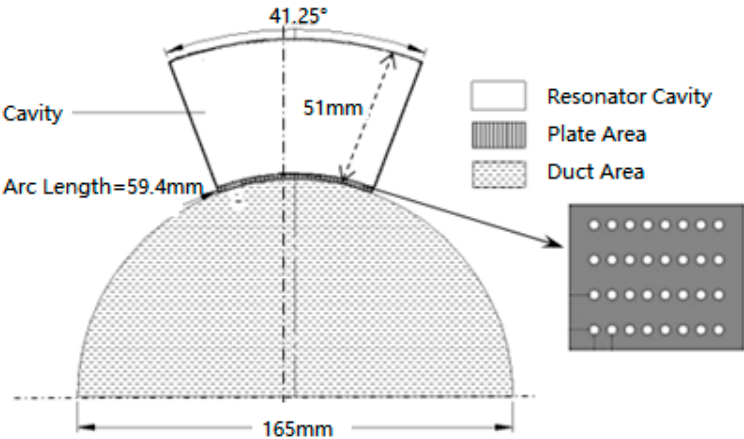
Figure 3. The position and shape of the perforated liner on the test rig.